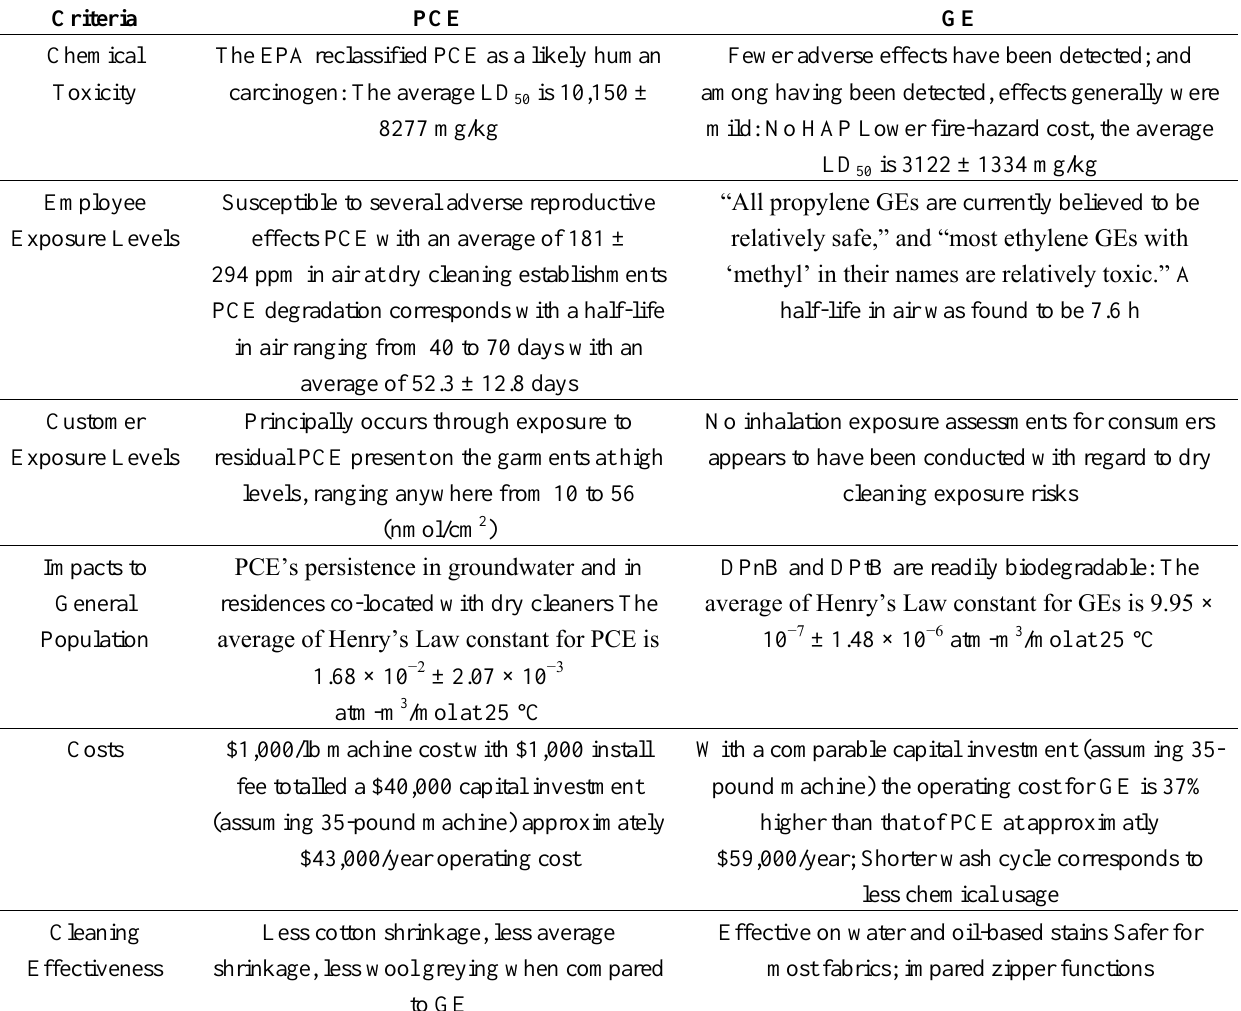
Table 4. Comprehensive results for PCE vs.